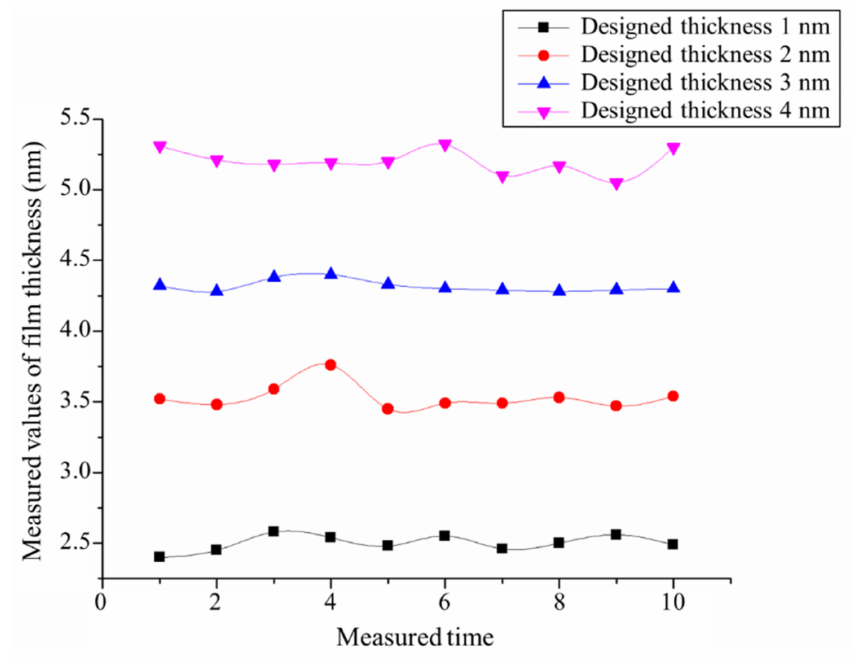
Figure 4. The thickness of Al 2 O 3 film measured at 10 different points.